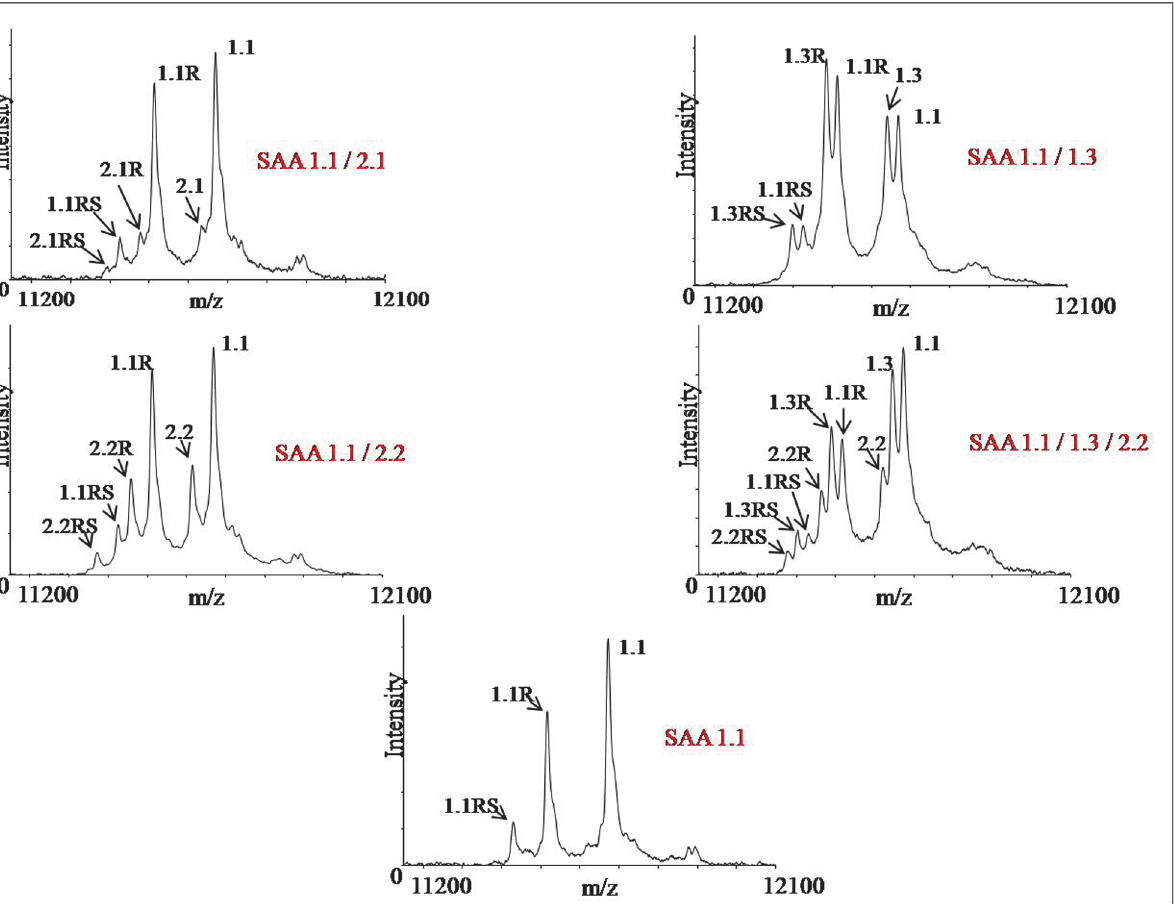
Figure 1. MALDI-MSIA-mass spectra of SAA from five different plasma samples showing all the variant forms and truncations (missing terminal – R and/or terminal – RS). All samples express SAA 1.1 with R and RS